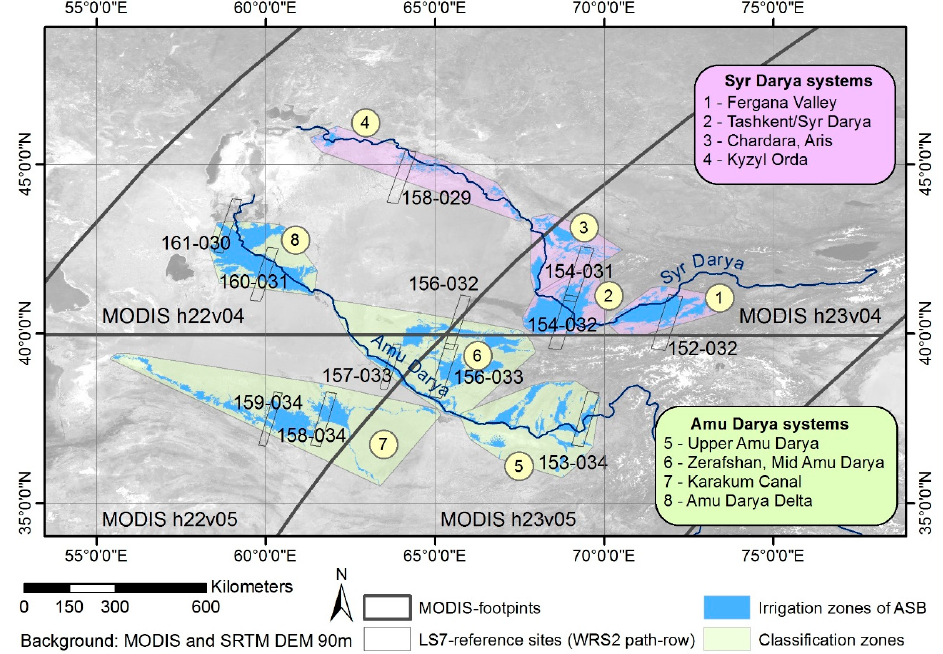
Figure 3. MODIS granules, Landsat-7 ETM+ reference sites named according to the WRS path and rows, and classification zones in the catchments of Syr Darya ( violet color ) and Amu Darya ( green color ); The irrigation zones in the ASB are highlighted in blue color; The background is composed from MODIS data and overlaid with an SRTM digital elevation model.